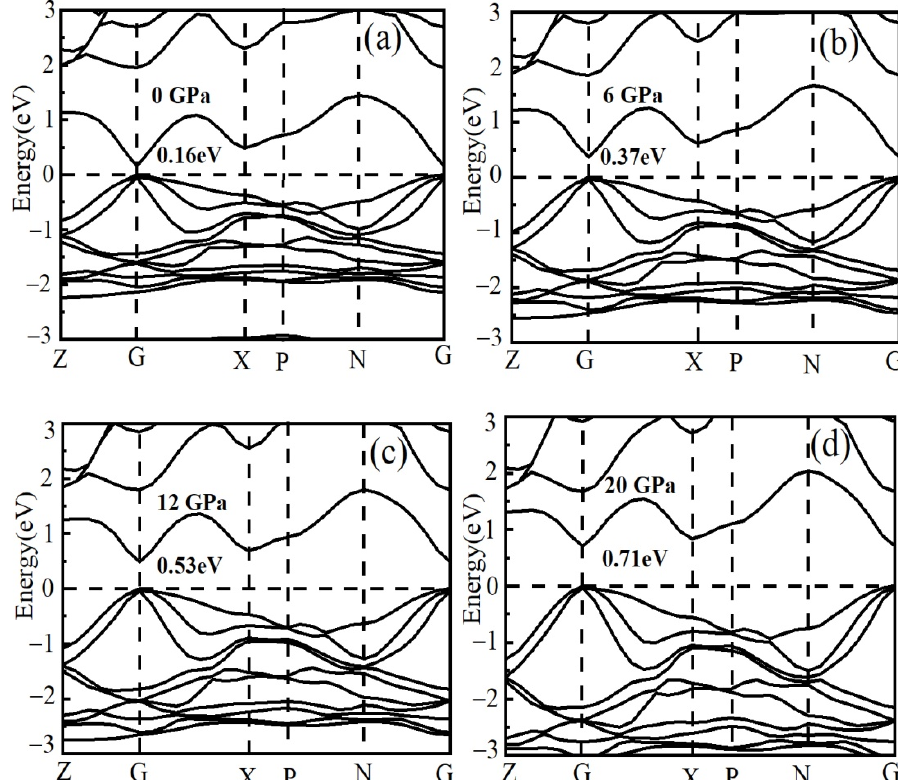
Figure 3. Band structure of Cu 2 ZnSnS 4 under compressive stress for ( a ) 0 GPa band structure; ( b ) 6 GPa band structure; ( c ) 12 GPa band structure; and ( d ) 20 GPa band structure.